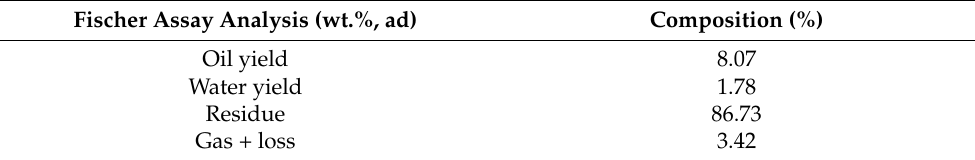
Table 1. Fischer assay analyses of the Fushun oil shale.